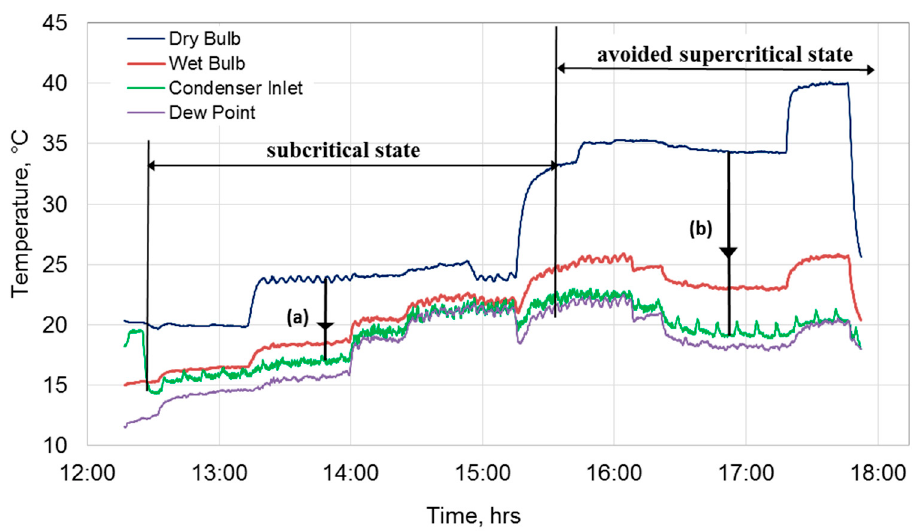
Figure 7. Impact of precooled air or the condenser inlet temperatures ( a ) reducing condensing temperature, ( b ) avoidance of transcritical